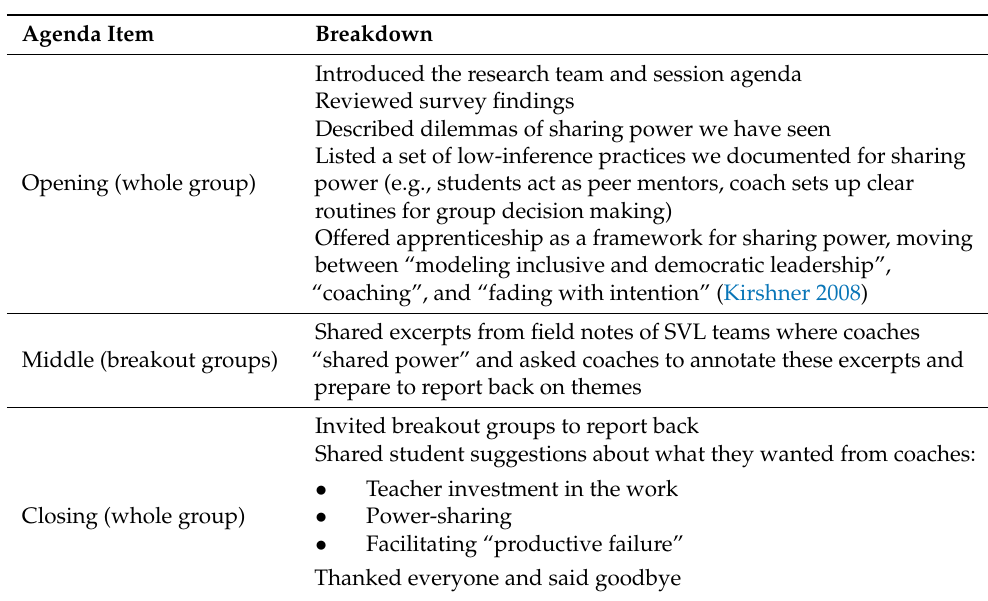
Figure 2. Starting breakout groups by asking for student expertise. Table 3. Student Session